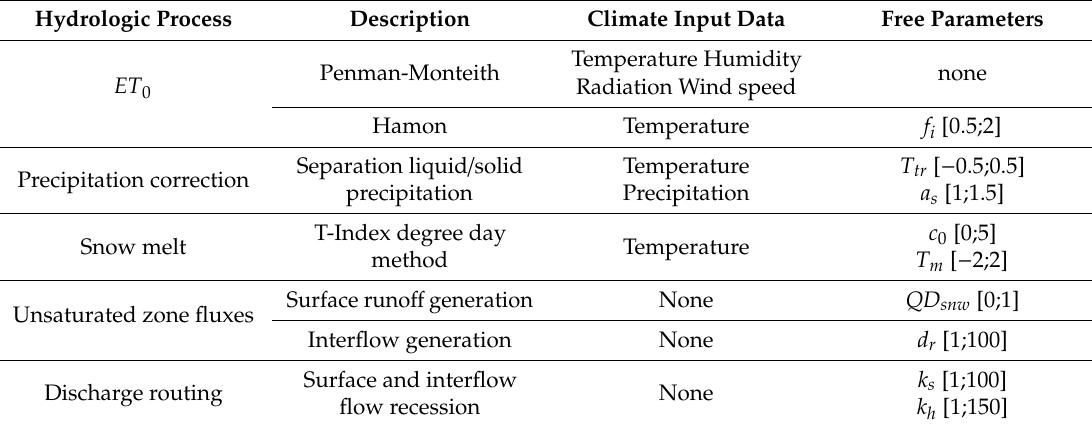
Table 2. Hydrologic modeling